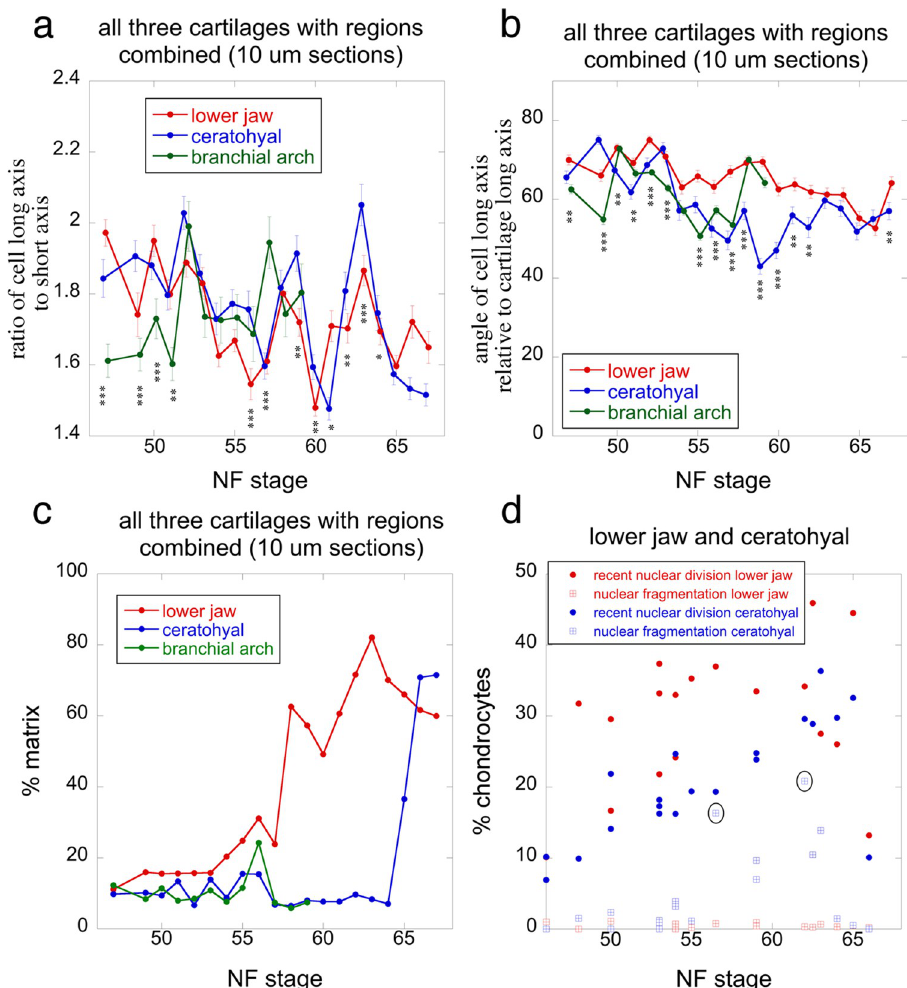
Fig 8. Cell shape, orientation, percent matrix and nuclear fragmentation for the three cartilages at NF 47–67. (a) ratio of cell long axis to short axis. (b) angle of cell long axis to cartilage long axis. (c) percent matrix. (d) percentage of chondrocytes showing signs of recent nuclear division and nuclear fragmentation. Data for a-c are from the same photos and cells used for Fig 7; error bars in a and b are standard errors; asterisks indicate a significant difference among cartilages for a stage; one asterisk means p < 0.05, two means p < 0.01, and three means p < 0.001 using ANOVA in R. Data for d are from 63X DAPI fluorescence photos of a large central portion of each cartilage from 1–2 specimens at each stage; ovals indicate the two highest values; see Materials and Methods and Fig 2B for descriptions and images of nuclear fragmentation and recently divided